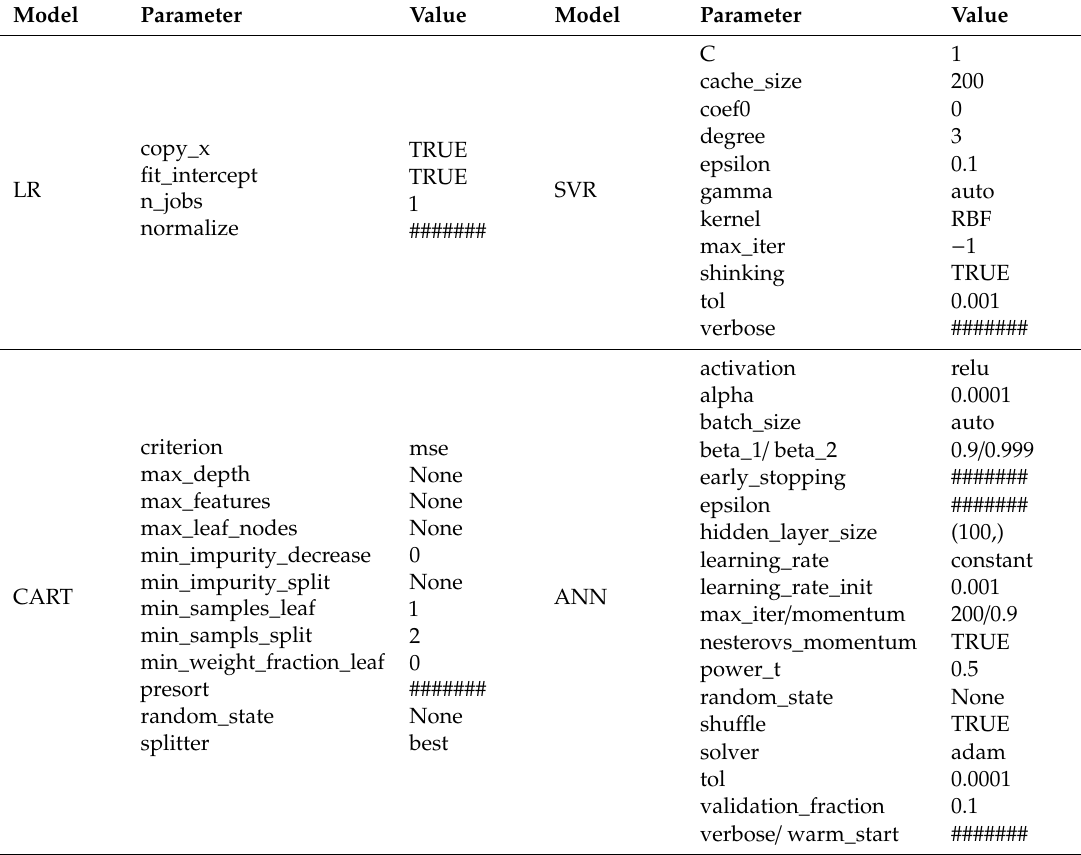
Table 3. Models with default parameter settings.